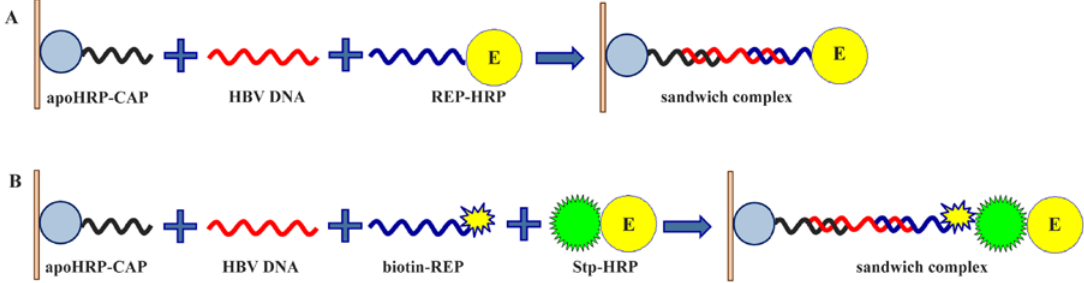
Figure 1. Schematic illustration of the microplate chemiluminescent assays for HBV DNA detection using ( A ) HRP-REP conjugate and ( B ) biotinylated REP and HRP-streptavidin conjugate as signaling systems.